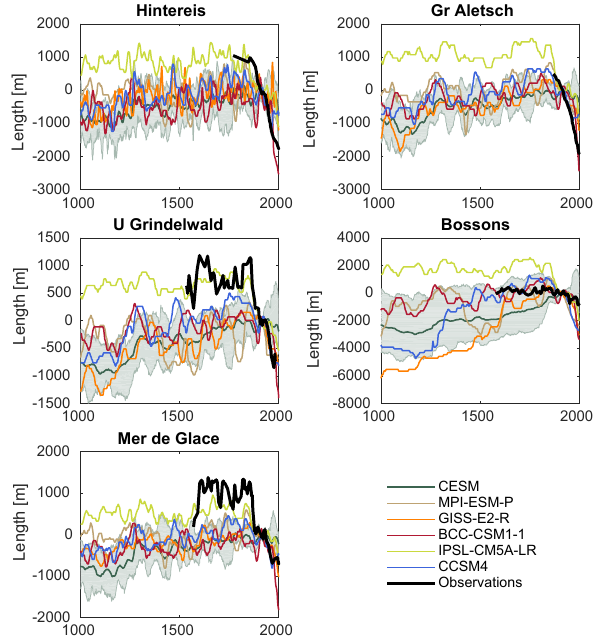
Figure 2. Observed and simulated length for five selected glaciers in the Alps. The shaded area represents the range of the ensemble of simulations driven by CESM outputs. The reference period is